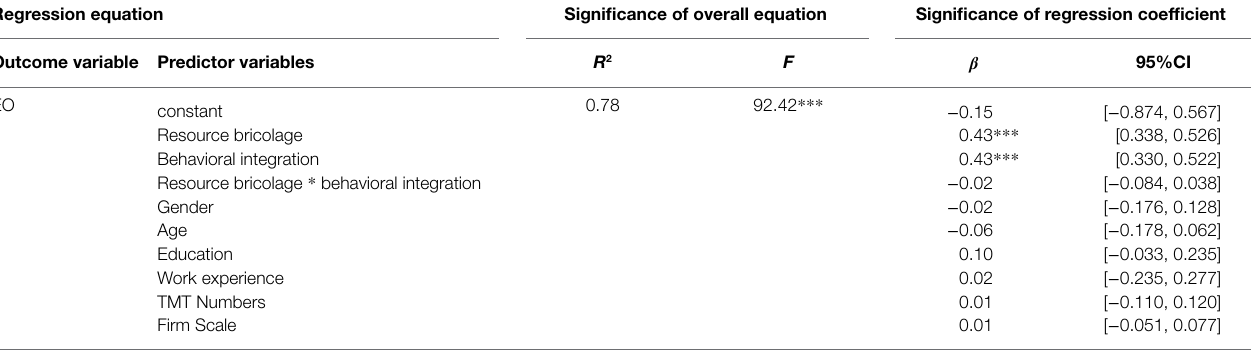
TABLE 4 | The moderating effect of TMT behavioral integration.